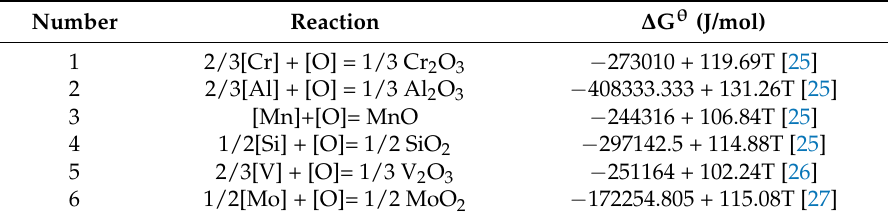
Table 4. Chemical reactions and Gibbs Energy ∆ G θ